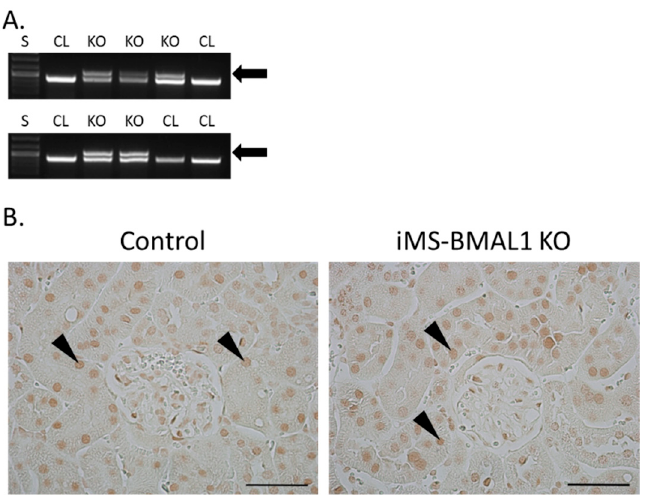
Figure 1. BMAL1 expression is not altered in the kidneys of iMS-BMAL1 KO. ( A ) Recombination PCR assay in skeletal muscle tissue. The forward and reverse primers for the floxed Bmal1 allele yielded a 431 bp band, which was seen in iMS-BMAL1 KO and control mice. A second forward primer detected the recombined product with a 572 bp band, which was only seen in iMS-BMAL1 KO. Arrow indicates band found in knockout mice. ( B ) Representative images of kidney sections demonstrating BMAL1 protein expression in control and iMS-BMAL1 KO mice. Figure shows the renal cortex. Markers indicate positively BMAL1-stained cells. Scale bar represents 0.05 mm. Mice shown in figure are from the phase advance cohort. S = standards ladder; CL = control mice; KO = iMS-BMAL1 KO mice.